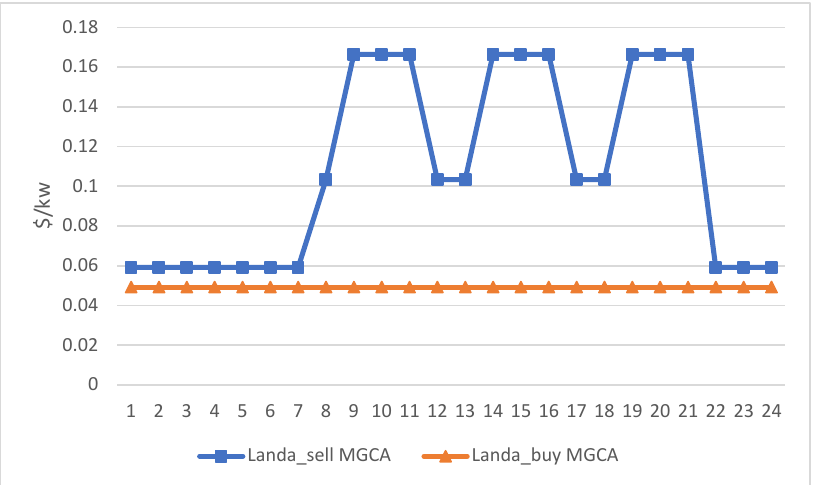
Figure 6. The basic price of buying and selling energy from the grid output by the PSO model in model 1.